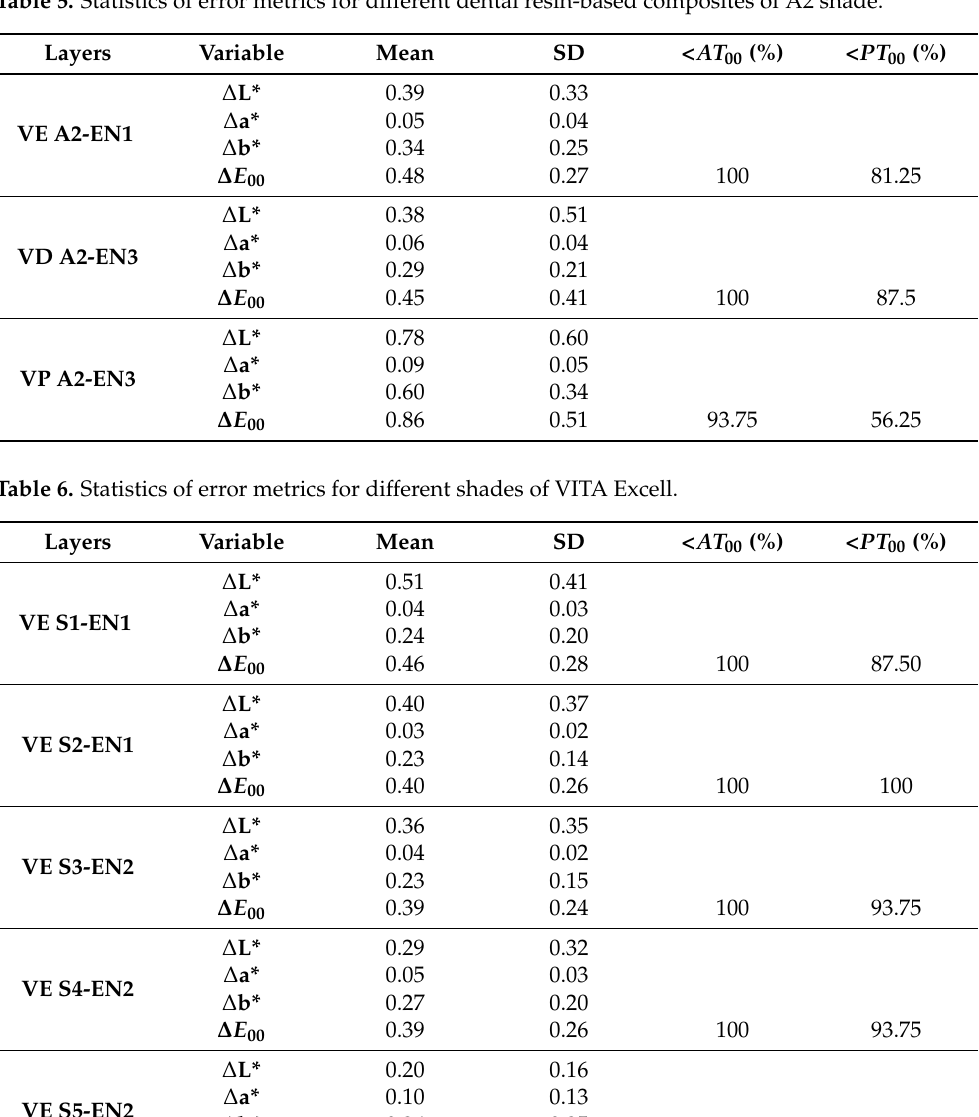
Table 5. Statistics of error metrics for different dental resin-based composites of A2 shade.